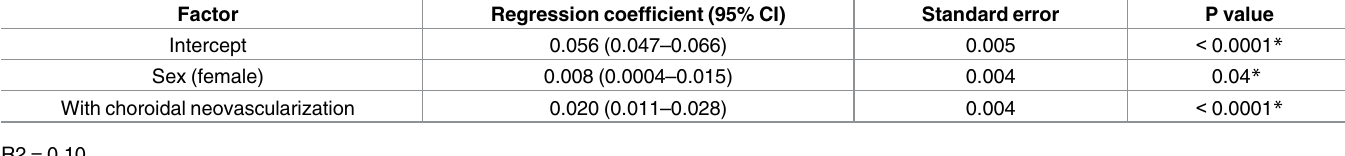
Table 6. Multiple regression analysis of the changes in axial length per year by sex and choroidal neovascularization.